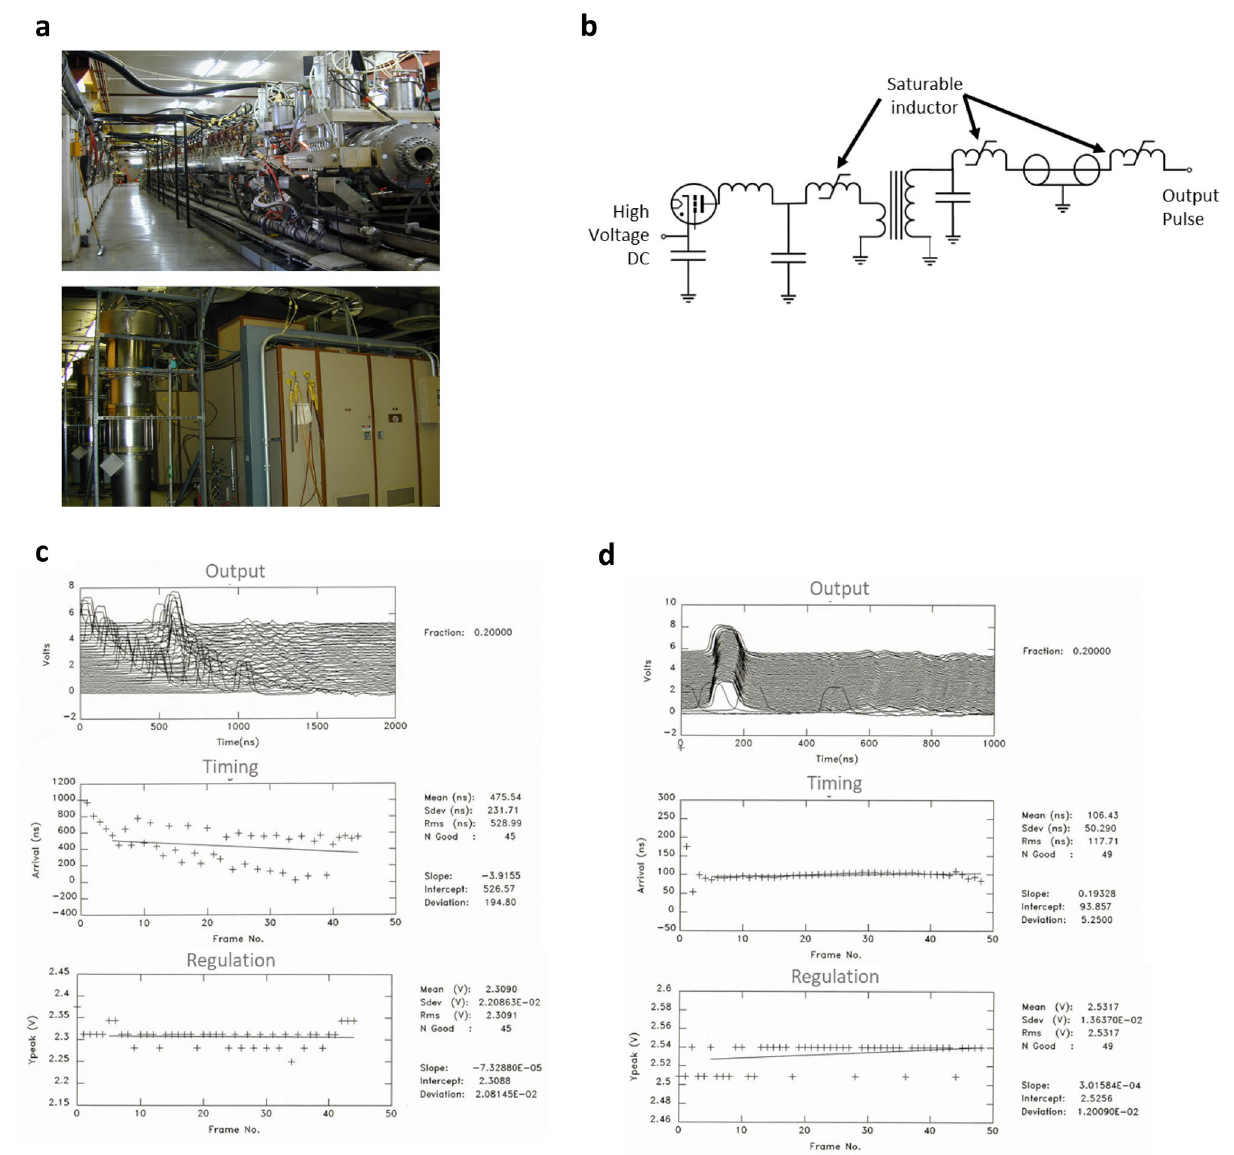
Figure 5. Development of high repetition rate LIAs. ( a ) The Experimental Test Accelerator-II (ETA-II) at Lawrence Livermore National Laboratory nominally rated at 3000-A beam current, 6.5 MeV, at 5 kHz (top) and the pulsed sources using thyratron gas switches and a Melville pulse compression transmission line (bottom). ( b ) Schematic of the pulsed source. ( c , d ) Effect of stabilizing the repeatability of the pulsed sources at 5000 Hz. ( e , f ) First tests on high gradient cavities operating at 42 kV per cell using SF 6 insulation gas; we anticipate better than twice the performance using oil insulation. ( g , h ) Testing silicon carbide switching using the optical transconductance varistor (OTV) technology 64